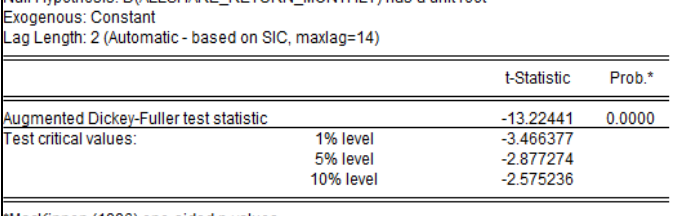
FIGURE 3: Augmented Dickey-Fuller (ADF) Test - First Difference Source: Eviews